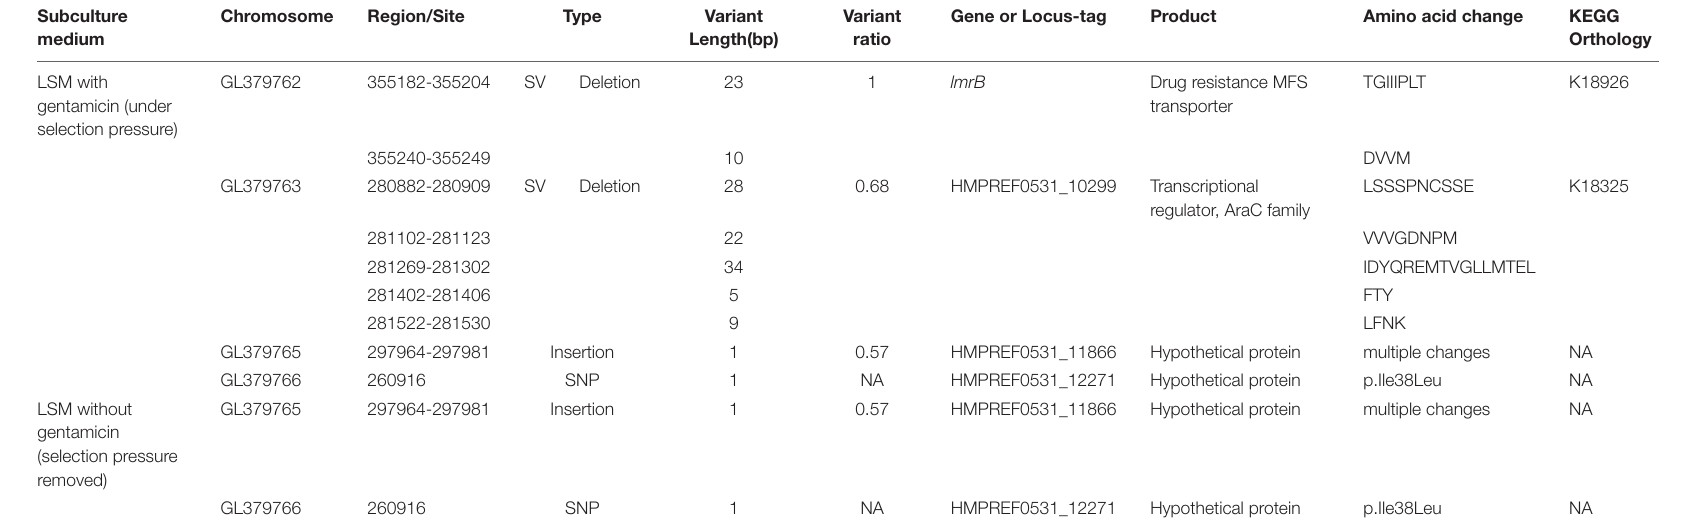
Hypothetical protein